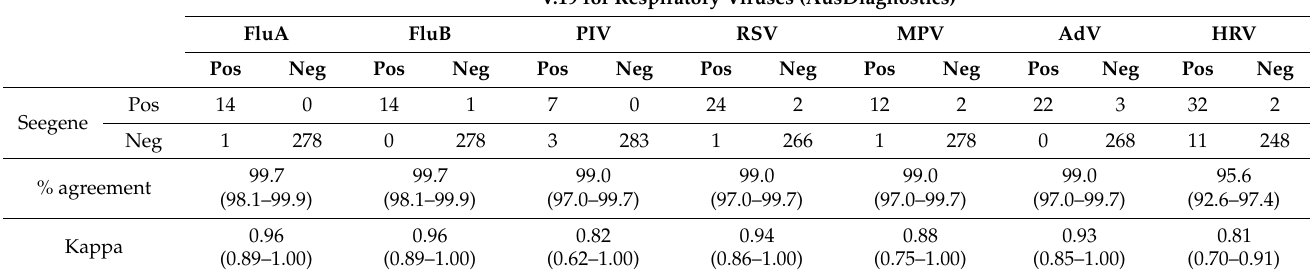
Table 4. Results comparison between the Respiratory Viruses 16-Well Assay V.19 and the Allplex™ RV Essential Assay for influenza A (FluA), influenza B (FluB), parainfluenza (PIV), respiratory syncytial virus (RSV), metapneumovirus (MPV), respiratory strains of adenovirus (AdV), and human rhinovirus